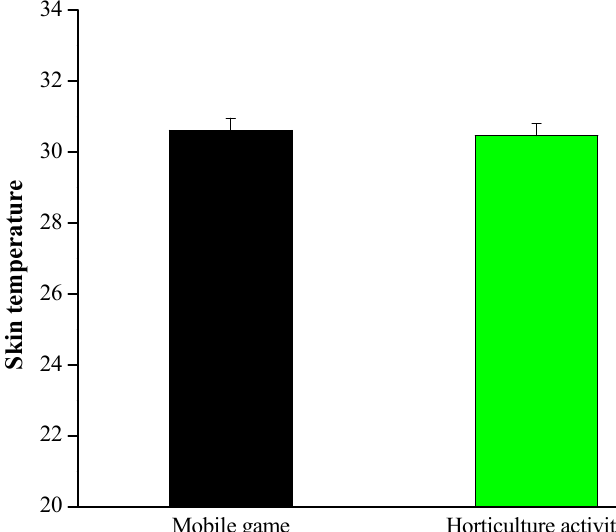
Figure 5. SKT during the 5 min experimental period; n = 26, mean ± SE, p > 0.1 determined by the paired t -test.